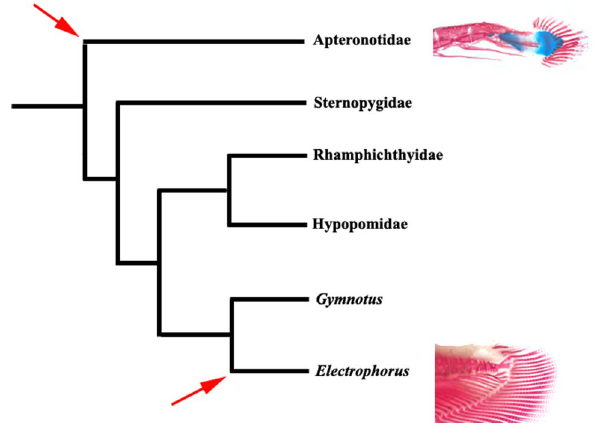
Figure 6. Phylogenetic relationships in Gymnotiformes based on [ 23,24,45 ] illustrating most parsimonious hypothesis for origins of caudal skeleton. Electrophorus + Gymnotus = Gymnotidae; arrows indicate presence of caudal-fin complex in Apteronotidae and Electrophorus.